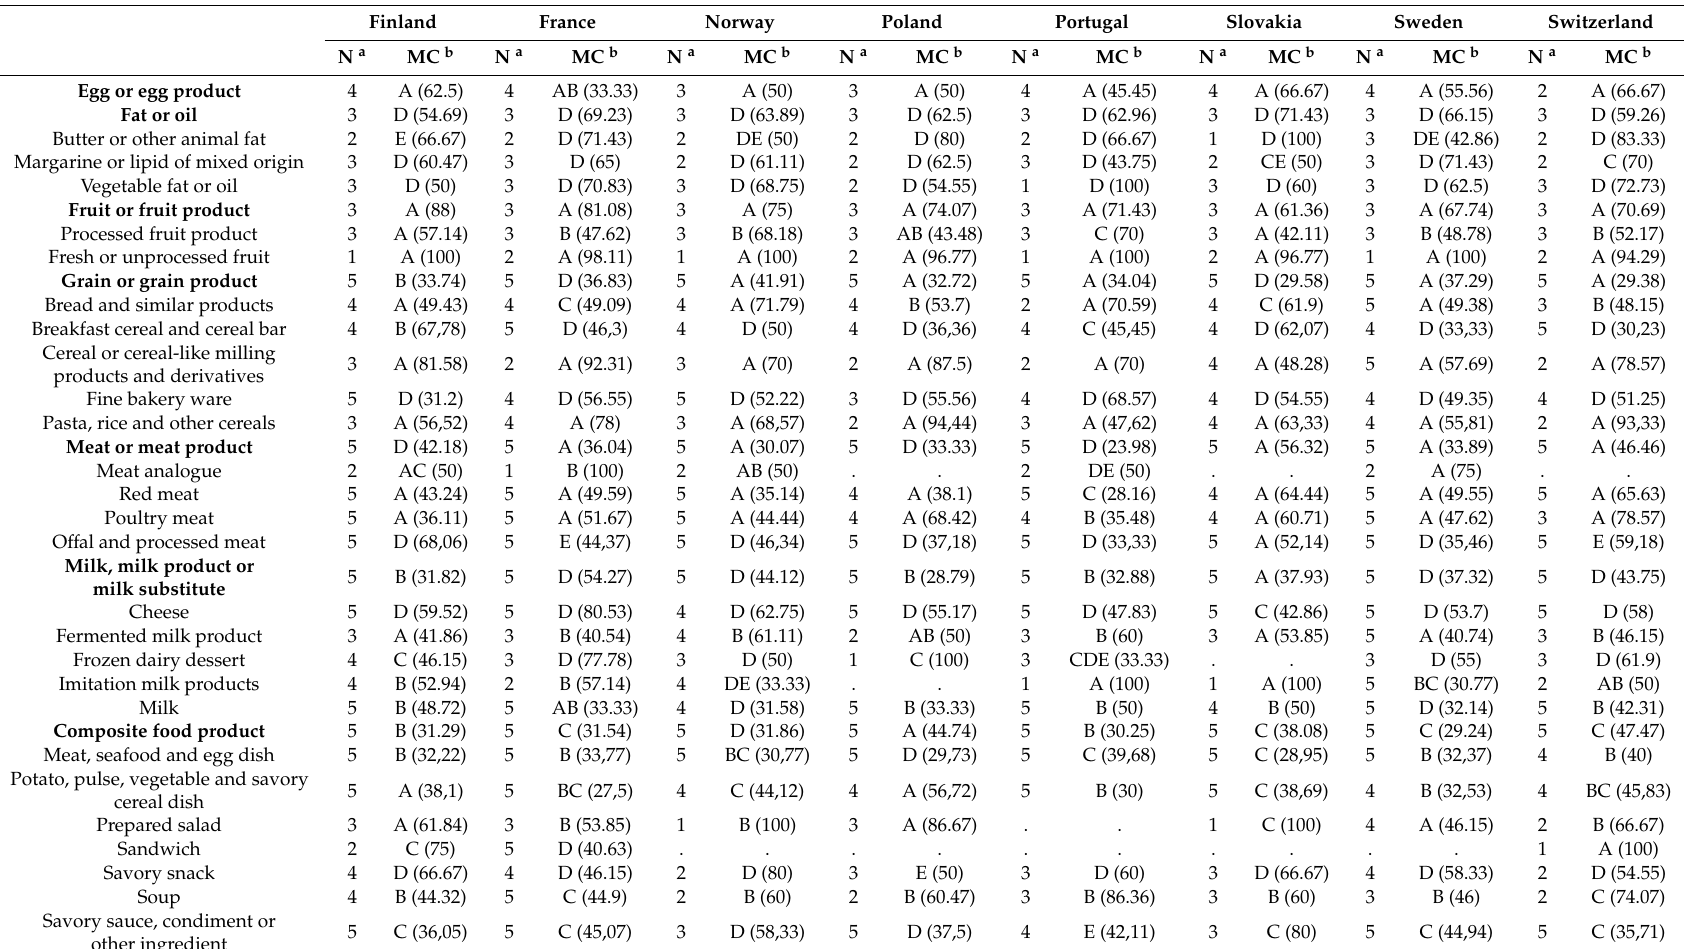
Table 2. Discriminating performance of the Nutri-Score in the eight